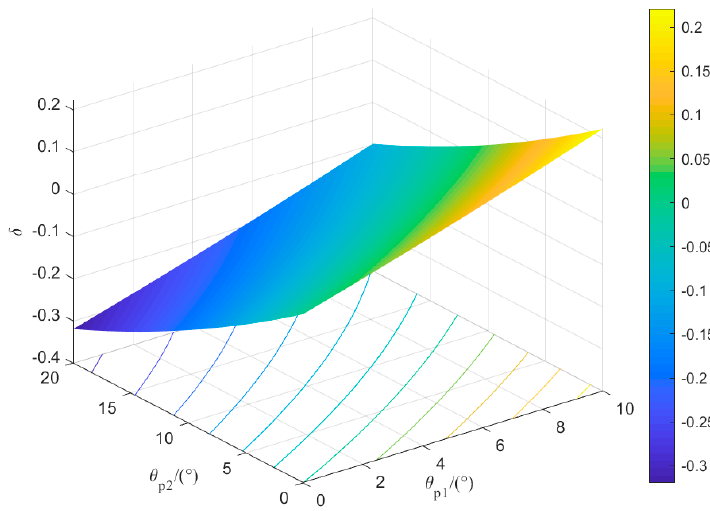
Figure 6. Change in δ with the upper and lower divergence angles.